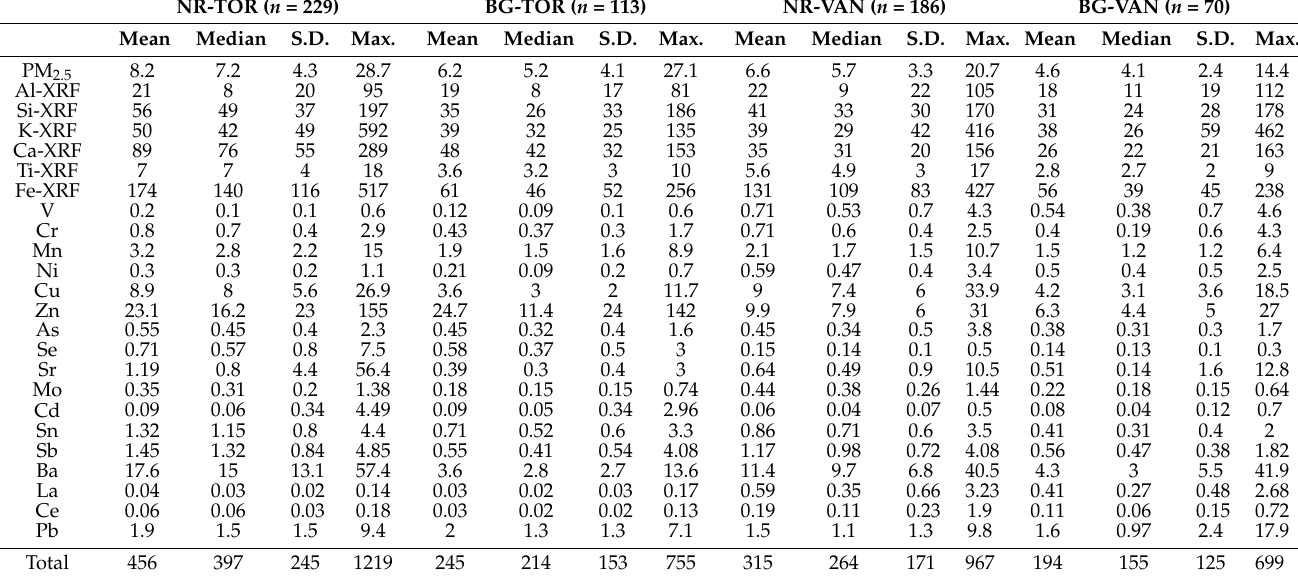
Table 2. Summary statistics for PM 2.5 (in µ g m − 3 ) and elemental concentrations (in ng m − 3 ) at Toronto and Vancouver sites. NR-TOR ( n = 229) BG-TOR ( n = 113) NR-VAN ( n = 186) BG-VAN ( n = 70) Mean Median S.D. Max. Mean Median S.D. Max.